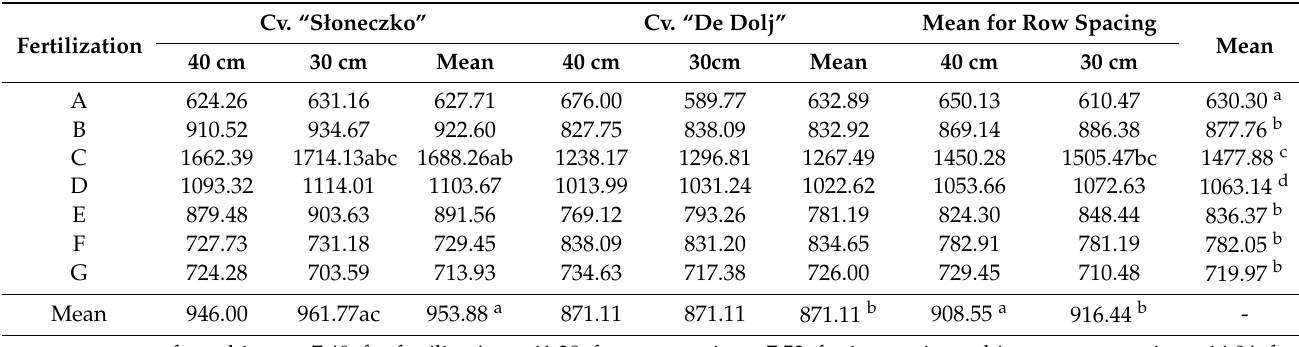
Table 5. Total polyphenols content in thyme raw material (mg GAE 100 g − 1